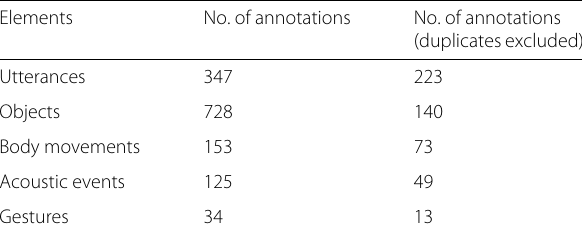
Table 10 Total number of the elements participating in COSMOROE relations in GWW, with and without multiple labels